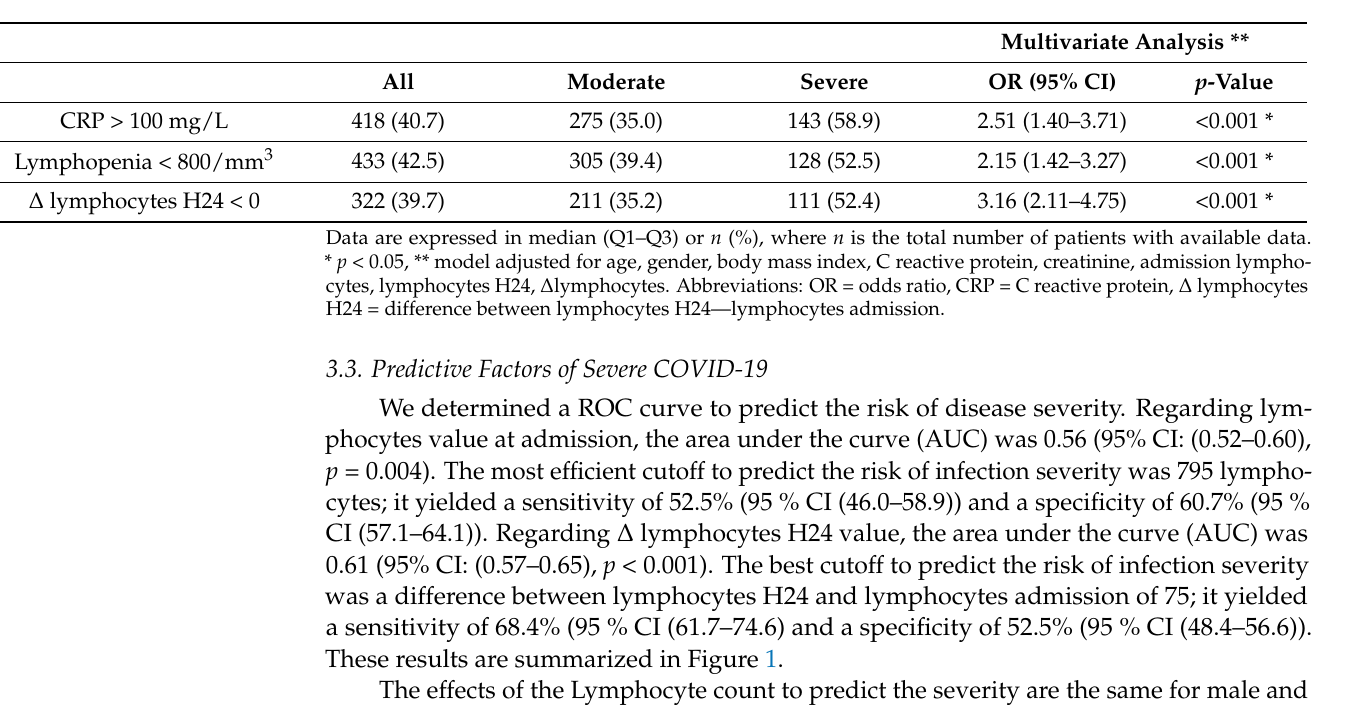
Table 2. Biochemical factors associated with severe COVID-19 (admission to the